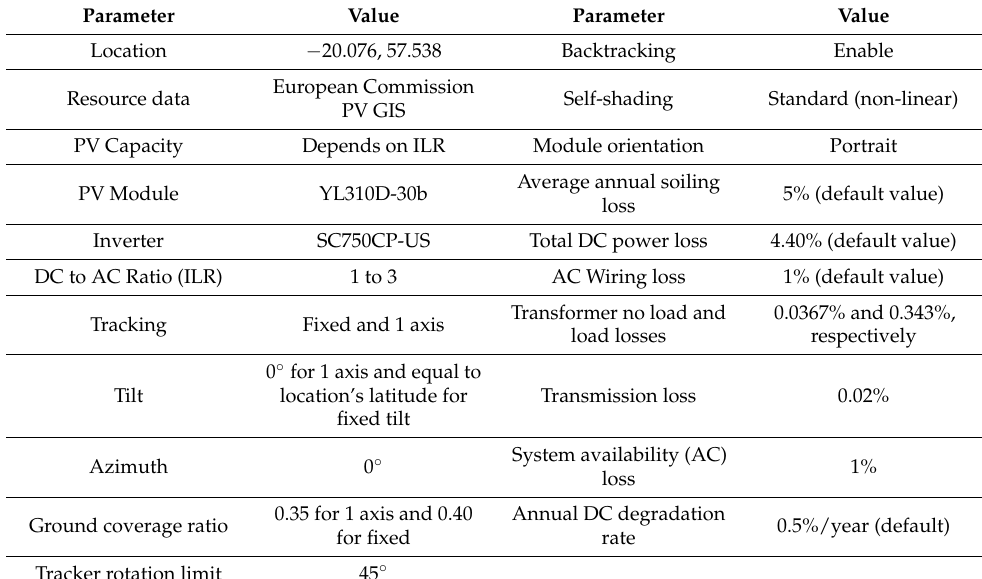
Table 2. Key technical